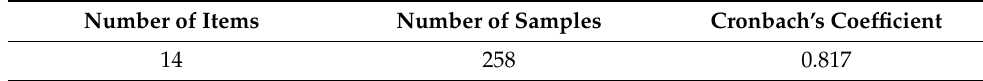
Table 3. Cronbach reliability analysis.